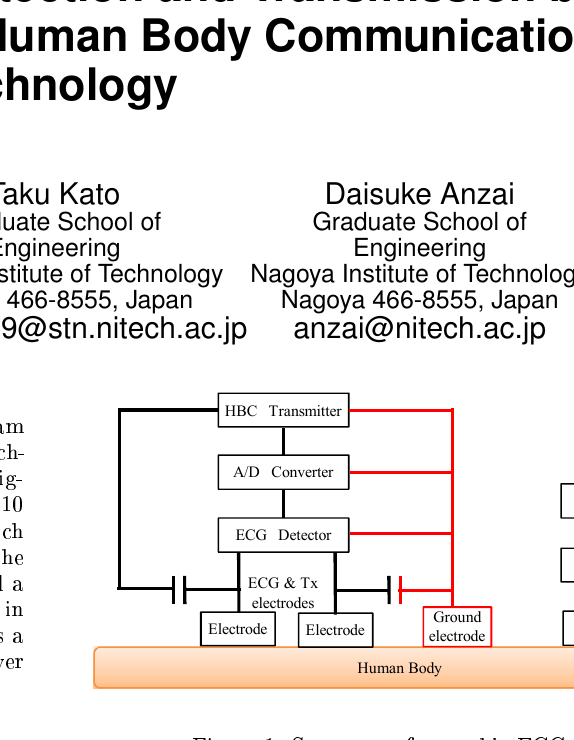
Figure 1: Structure of wearable